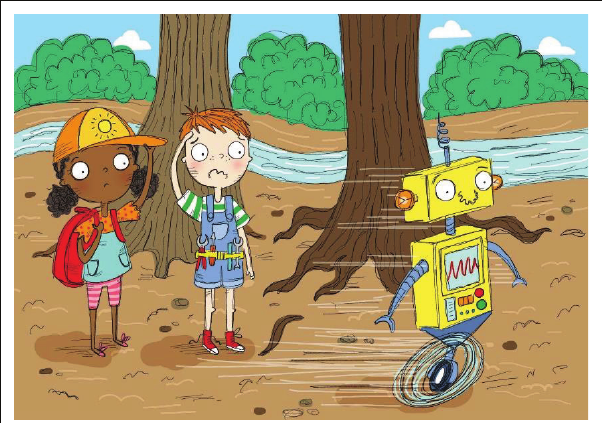
FIGURE 3: An example of a scene in Alex gets stuck where the robot’s code must be